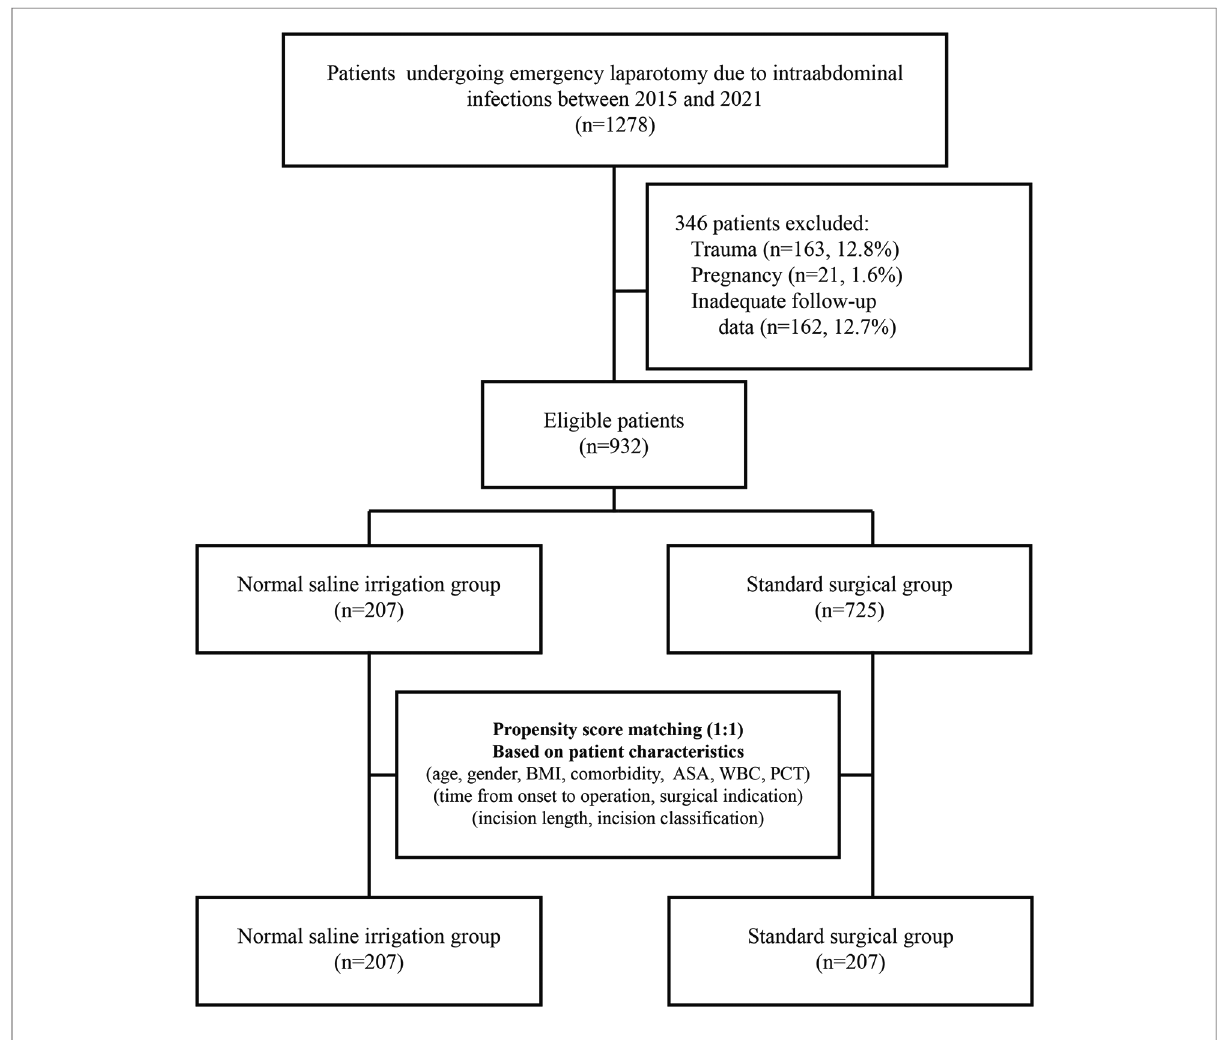
FIGURE 1 Flowchart of the